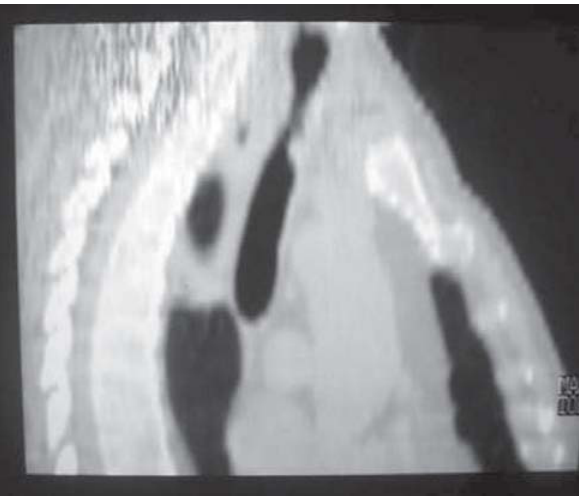
Fig. 1 - Tomografia computadorizada de tórax mostrando estenose traqueal importante (seta)